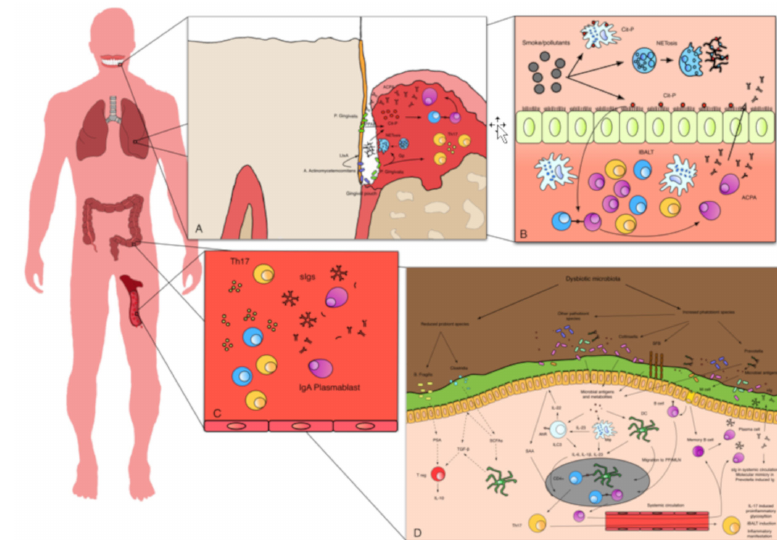
Figure 1. Immune abnormalities in at-risk subjects: ( A ) At the periodontal level, P. gingivalis generates citrullinated peptides through PPAD. Moreover through gingipains, P. gingivalis increases the polarization versus Th17 and induces NETosis. Aggregatibacter can also induce the formation of citrullinated peptides, through the production of Lxt-A and the induction of NETosis. Citrullinated peptides, recognized by specific B cells, induce ACPA production. ( B ) In the lung mucosa, smoke and air pollutants induce the formation of citrullinated antigens and NETosis. Mucosa reacts through the formation of iBALT and the local production of ACPAs, which can be detected in local secretions. ( C ) In systemic circulation, there is an increase of circulating Th17 and a reduction of Treg. T cells present an abnormal hypoglycolytic and hyperproliferative phenotype, and there is an increased production of pro-inflammatory cytokines, such as IL-17. Moreover, there is an enrichment of circulating IgA plasmablasts, as well as secretory IgA and IgM. ( D ) In gut mucosa, dysbiotic microbiota limits the normal induction of Treg. Pathobiont species stimulate the activation of DC, macrophages and ILC3, the polarization towards Th17, and the activation of the IL-23 / IL-17 axis. Locally produced Th17 can migrate through systemic circulation in other sites, inducing inflammation, abnormal Ig glycosylation, and iBALT formation. Specific B cells directed against luminal antigens can be activated in Peyer’s patches or in local lymph nodes, migrating back in lamina propria where they can produce secretory Igs. Some of these B cells recognize antigens that, through molecular mimicry, cross react with self-antigens. Cit-p: citrullinated proteins; PPAD pathogen PAD; Gp: gingipains¸Ltx-A: leukotoxin A; iBALT: inducible bronchus associated lymphatic tissue; sIgs: secretory immunoglobulins; PSA: polysaccharide A; SCFAs: short chain fatty acids; SFB: segmented filamentous bacteria; AhR: aryl hydrocarbon receptor; SAA: serum amyloid A; ILC3: innate lymphoid cells 3; DC: dendritic cells; M ϕ : macrophage; IL-: interleukin-; TGF: transforming growth factor; PP: Peyer’s patches; MLN: Mesenteric lymph